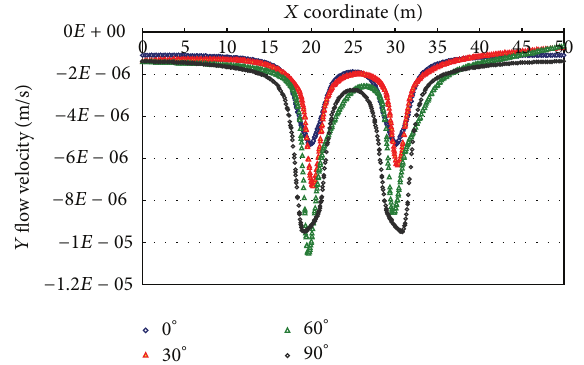
Figure 24: The flow velocity in 𝑦 direction along the horizontal section A-A 󸀠 for different numerical models, at 𝜃 = 0 ∘ , 30 ∘ , 60 ∘ , and 90 ∘ .